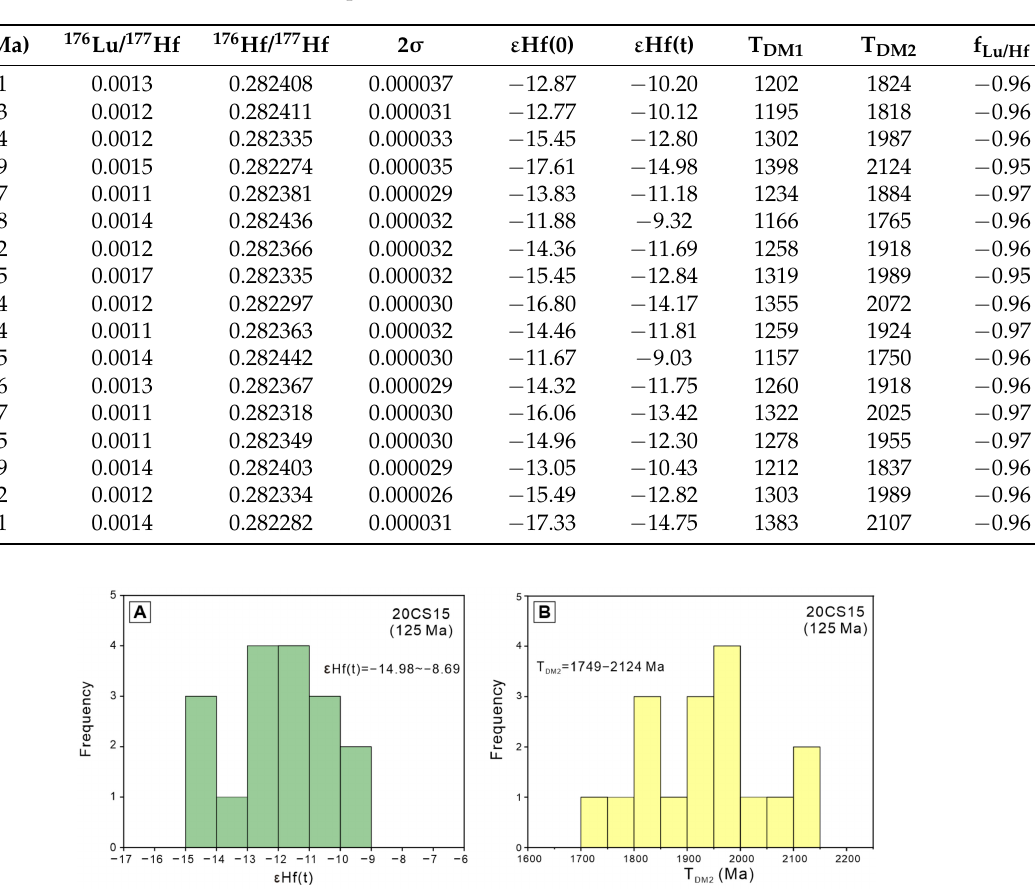
Table 3. Zircon Lu-Hf isotope data for kersantite (20CS15) from the Weishan area.